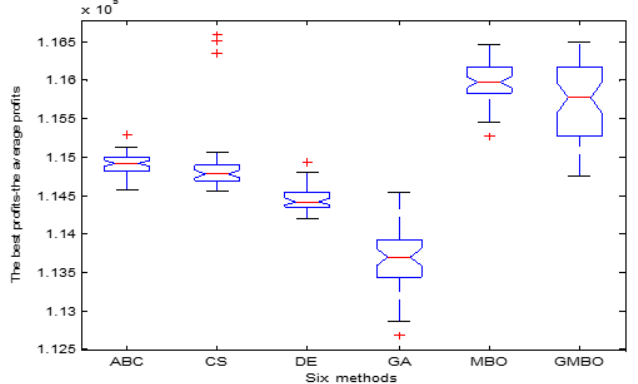
Figure 16. Boxplot of the best values on KP10 in 50 runs.